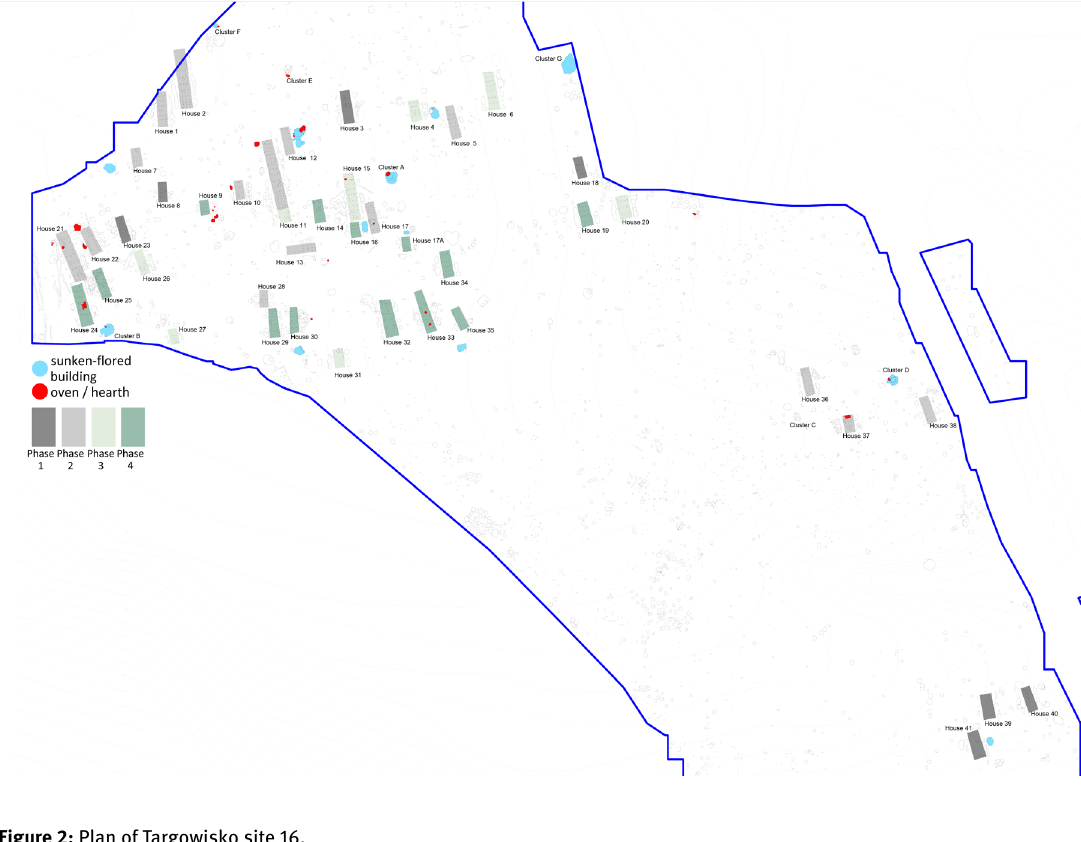
Figure 2: Plan of Targowisko site 16.